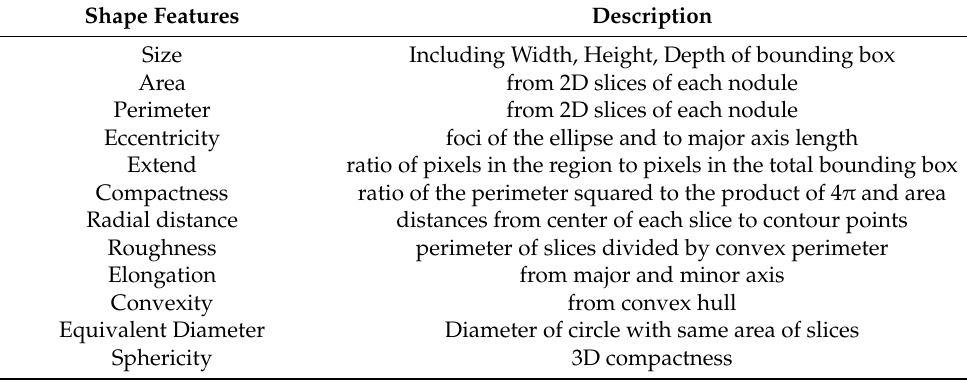
Table A1. List of extracted shape features from CT.